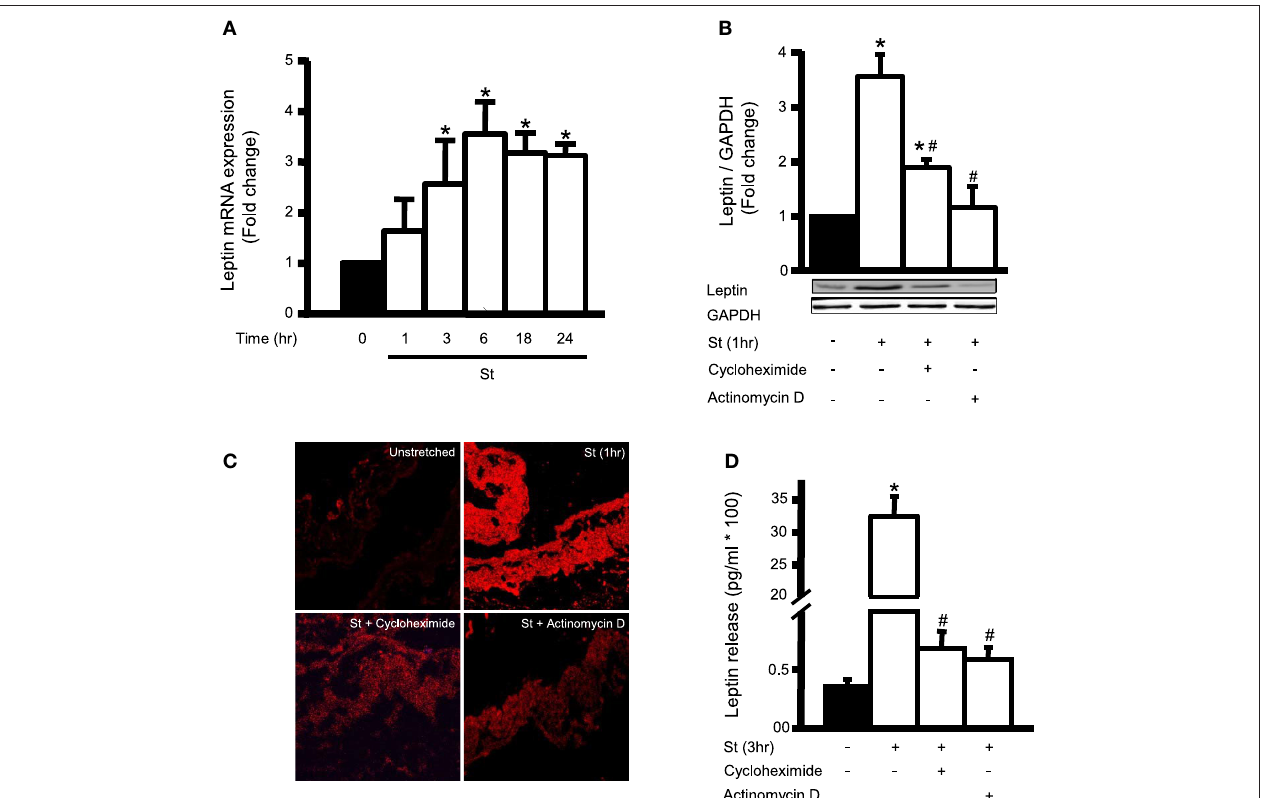
FIGURE 1 | Mechanical stretch upregulates endogenous leptin protein synthesis and is dependent on leptin RNA and protein synthesis. (A) Effect of mechanical stretch for 1, 3, 6, 18, or 24h on the mRNA expression of leptin ( n = 9–11). * p < 0.05 vs. unstretched (0min). (B) RPVs were pre-treated with the inhibitor of transcription actinomycin D (0.1 µ M) or the inhibitor of translation cycloheximide (1mM), followed by mechanical stretch for 1h (St 1h). Proteins were extracted, quantified, separated by SDS-PAGE, and immunoblotted using anti-leptin and anti-GAPDH antibodies. Leptin expression was normalized using GAPDH and fold change was normalized to the unstretched RPVs. (C) Representative microscopic images ( n = 4) for leptin detection in RPV wall after being mechanically stretched for 1h and pre-treated with actinomycin D (0.1 µ M) or cycloheximide (1mM). Leptin primary antibody was detected by Alexa 594-conjugated secondary antibody (red). (D) Leptin release into the extracellular media was measured using ELISA for mechanically stretched RPVs for 3h pre-treated with actinomycin D (0.1 µ M) or cycloheximide (1mM). Values are represented as mean ± S.E.M and normalized to unstretched RPVs ( n = 7–9). * p < 0.05 vs. unstretched (0 min). # p < 0.05 vs. St.